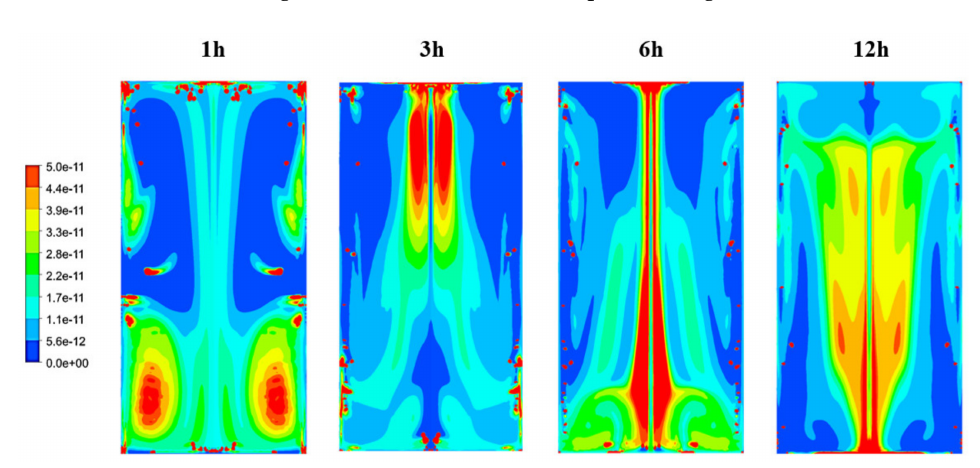
Figure 9. Time evolution of the volume fraction of lees throughout the first 12 h of the 24 h cycle (at 1 h, 3 h, 6 h and 12 h, respectively).